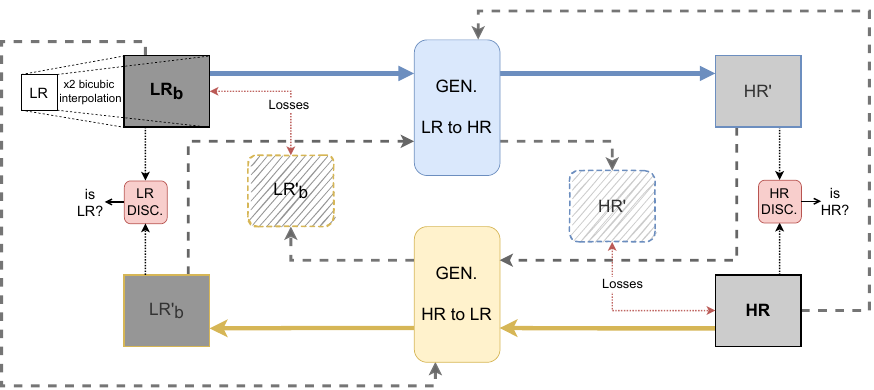
Figure 1. CycleGAN-based architecture with 6 blocks ResNet as a generator (for LR to HR and vice versa); losses represent adversarial, Sobel, cycled, SSIM and identity loss. Each cycle has its respective